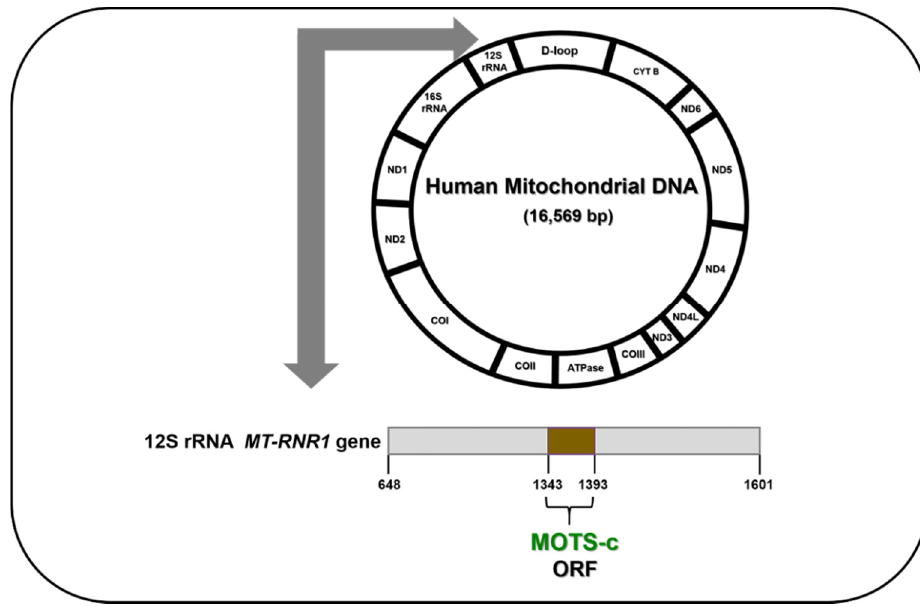
Figure 4. MOTS-c ORF in the human mitochondrial DNA.